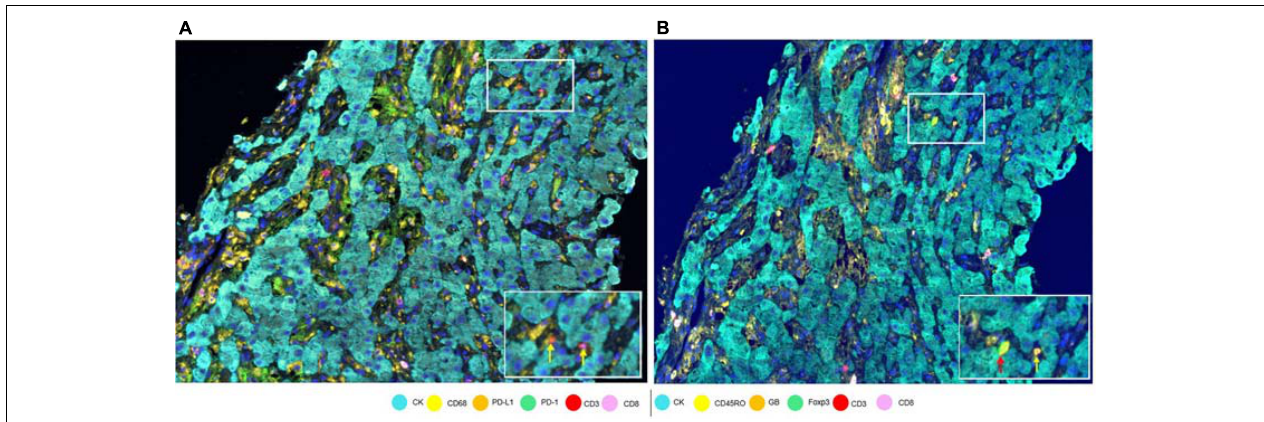
FIGURE 4 | Marker expression in a hepatocellular carcinoma sample. (A) Low-magnification image with white-framed rectangles showing two CD3 + cells (indicated by yellow arrows) seen with high magnification at the bottom right of the panel. (B) Low-magnification image with white-framed rectangles showing the same two CD3 + cells with co-localizations: CD3 + Foxp3 + CD45Ro (indicated by a red arrow) and CD3 + CD45Ro (indicated by a yellow arrow) seen with high magnification at the bottom right of the